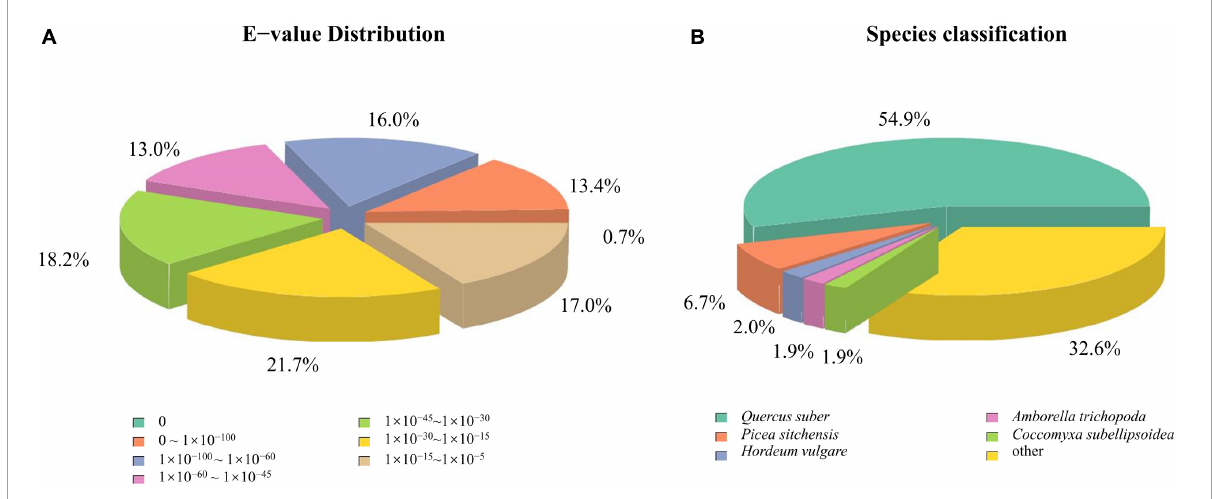
FIGURE5 Distribution of E -values (A) and species classification (B) of Dacrydium pectinatum unigenes when aligned in the National Center for Biotechnology Information (NCBI) non-redundant protein